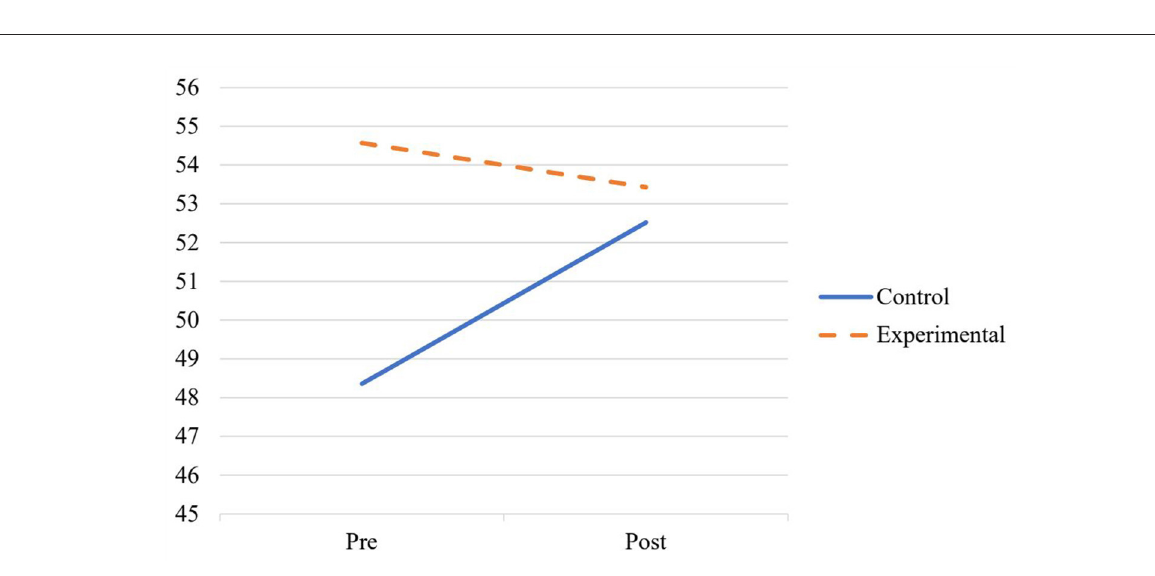
significant, F (1, 51) = 1.44, p = 0.236, η 2 p = 0.027. See Figure 1 for a depiction of the observed